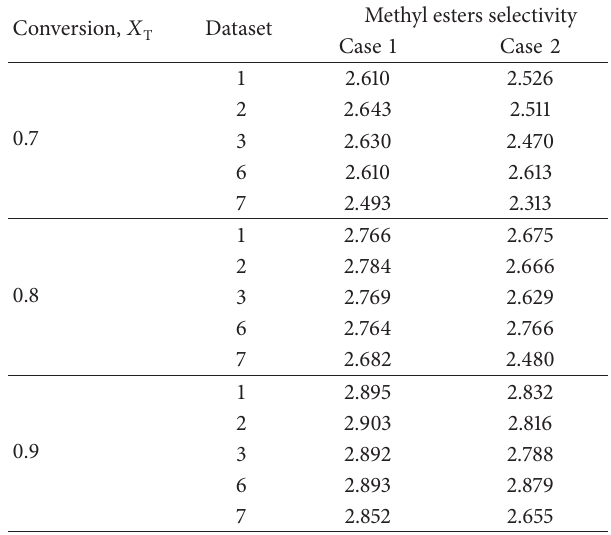
Table 2: Selectivity at 0.7–0.9 triglycerides conversion for datasets (1–3) and